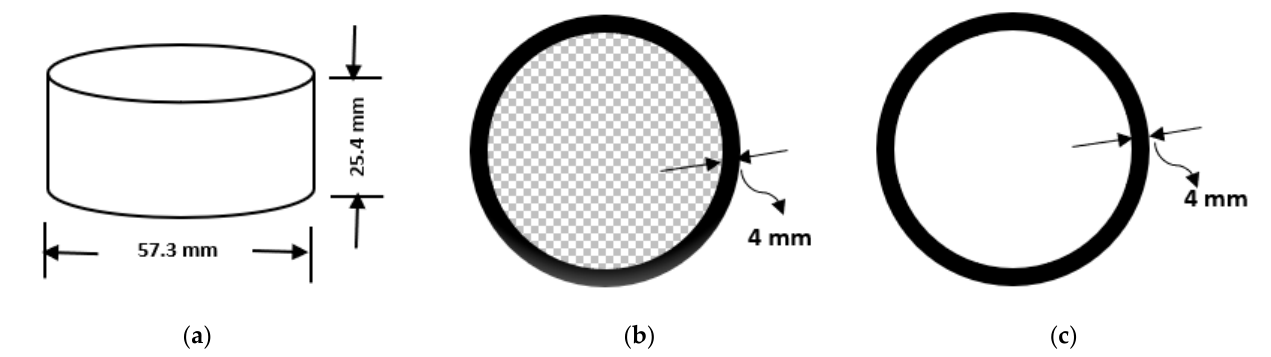
Figure 3. Dimensions of test specimen ( a ) Test specimen overall dimensions ( b ) X-sectional view of test specimen with internal cellular lattice structure ( c ) X-sectional view of hollow test specimen (solid part).